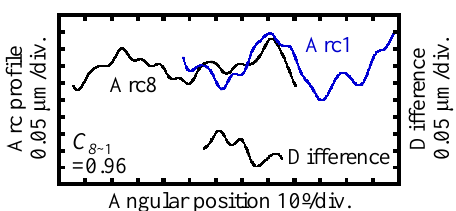
Figure 20. Relationship between Arc8 and Arc1 after the stitching operations.